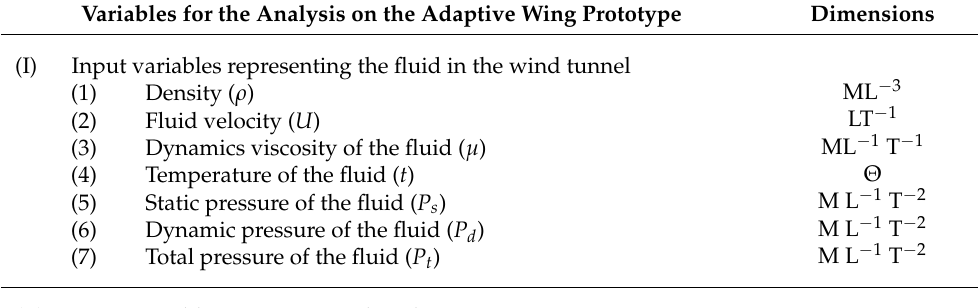
Table 2. Variables for the analysis of the adaptive wing. Variables for the Analysis on the Adaptive Wing